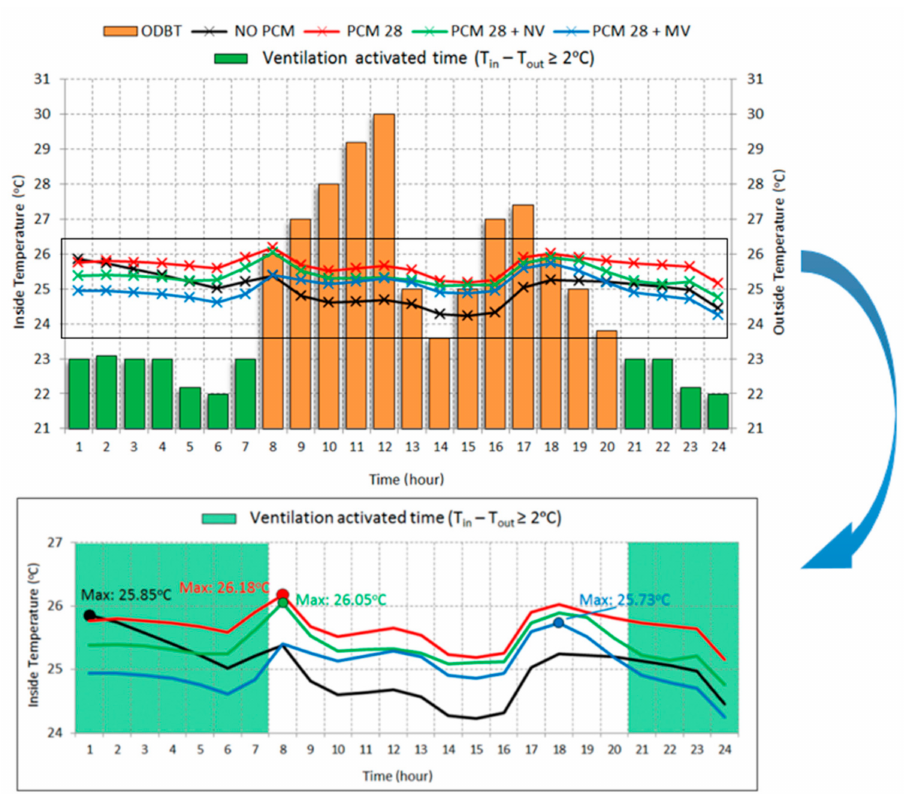
Figure 12. One-day analysis of the inside operative temperature of the building for the no PCM, PCM 28, PCM 28 + NV and PCM 28 + MV cases for the city of